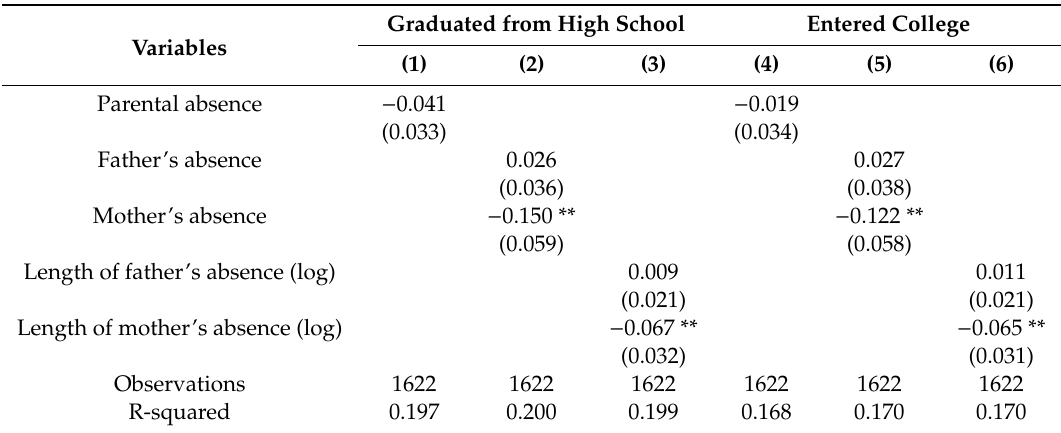
Table 11. Long-term e ff ect of parental absence on children’s educational